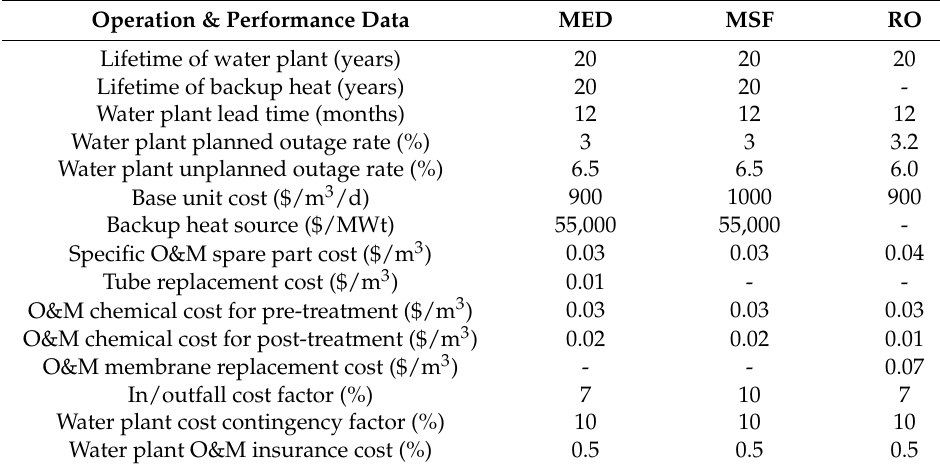
Table 8. Desalination model parameters